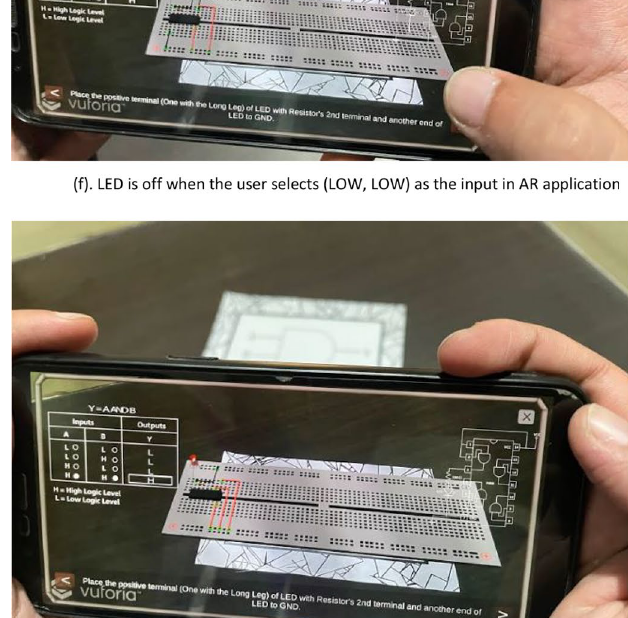
1. Figure 3a shows the main page of experiments on the topic “GATE” is as follows: 2. Figure 3b shows the experiment page of AND Gate as selected from the main menu. There are stepwise instructions written at the bottom of the screen with forward and backwards arrows. The forward arrow takes the user to the next step of the experi- ment and backward arrows shows the previous step of the experiment. The truth